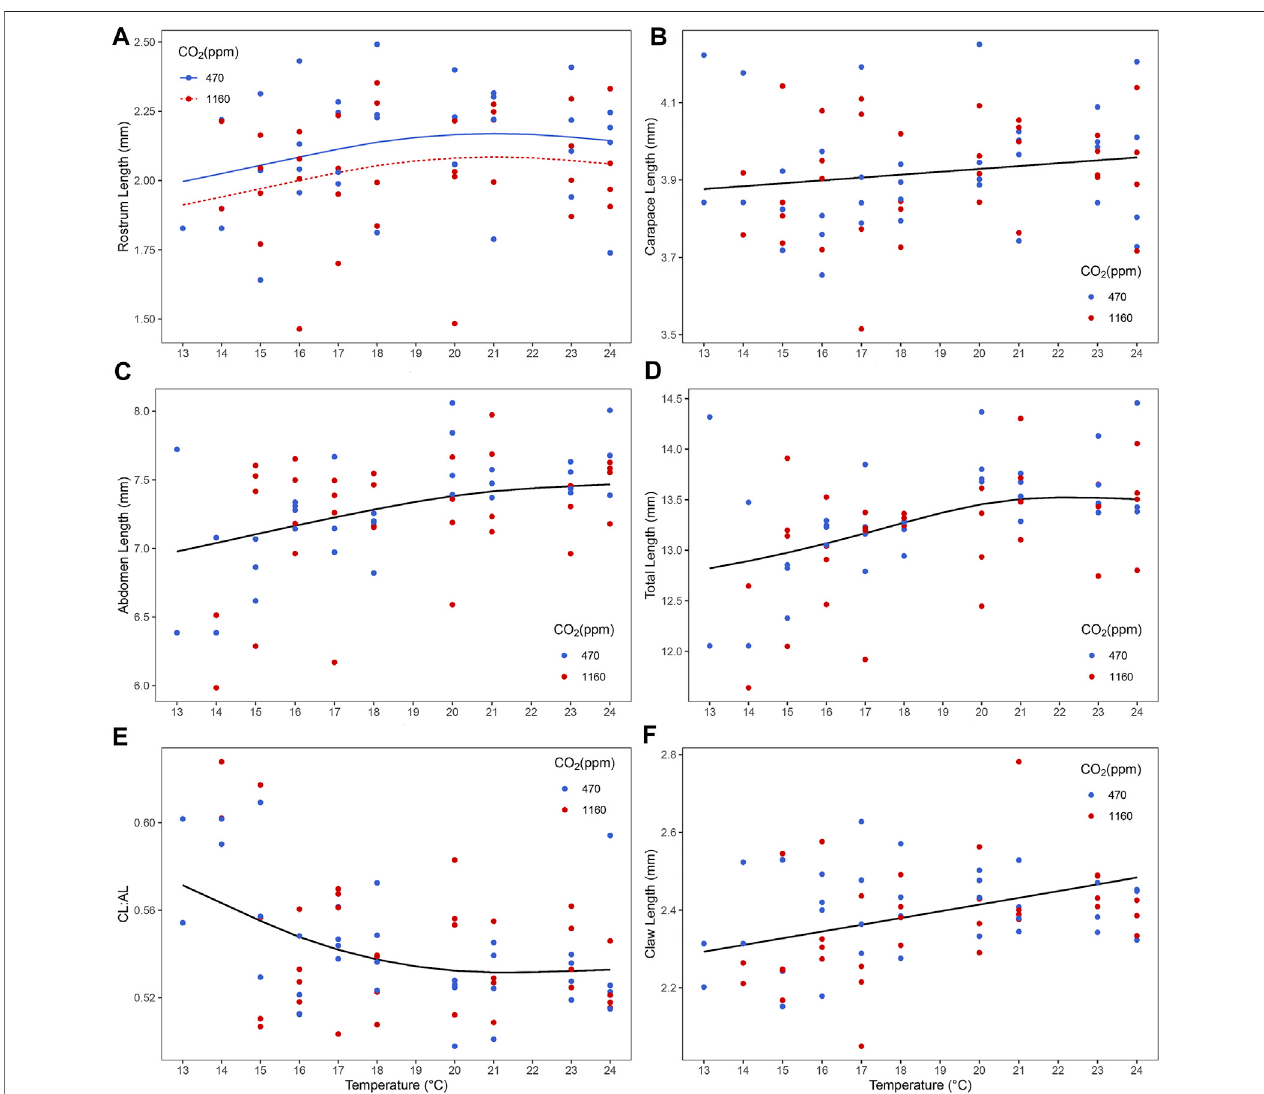
FIGURE 4 | Effect of temperature and ocean acidi fi cation on size and morphology of stage III Homarus gammarus larvae. (A) ocean acidi fi cation and temperature effect on rostrum length; and temperature effect on (B) carapace length [CL], (C) abdomen length [AL], (D) total length, (E) CL: AL ratio and (F) claw length. Each point represents the average response quanti fi ed in larvae originated from the same female. Curves correspond to smooths fi tted with the best (general additive) model, obtained after backwards model selection.